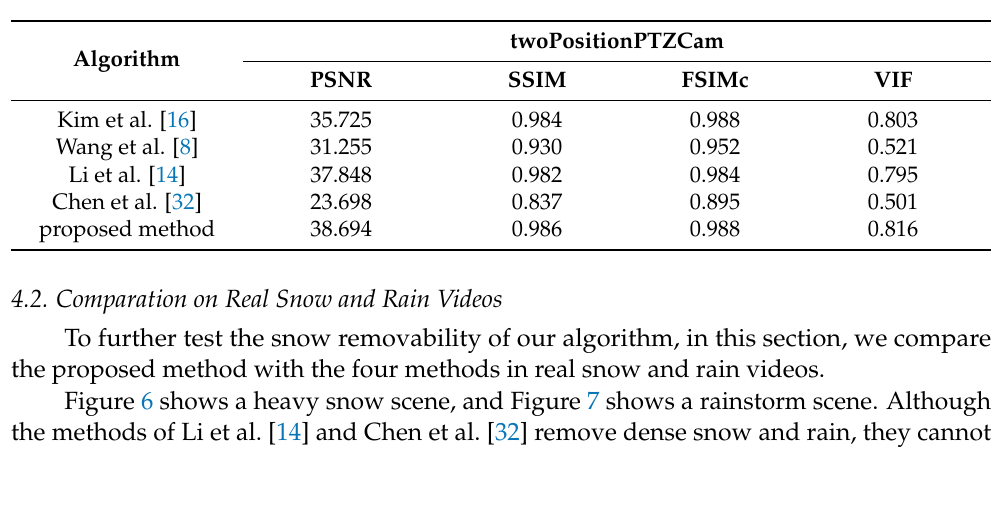
Table 2. Quantitative performance comparison of synthetic rain videos. All the results are the average of 200